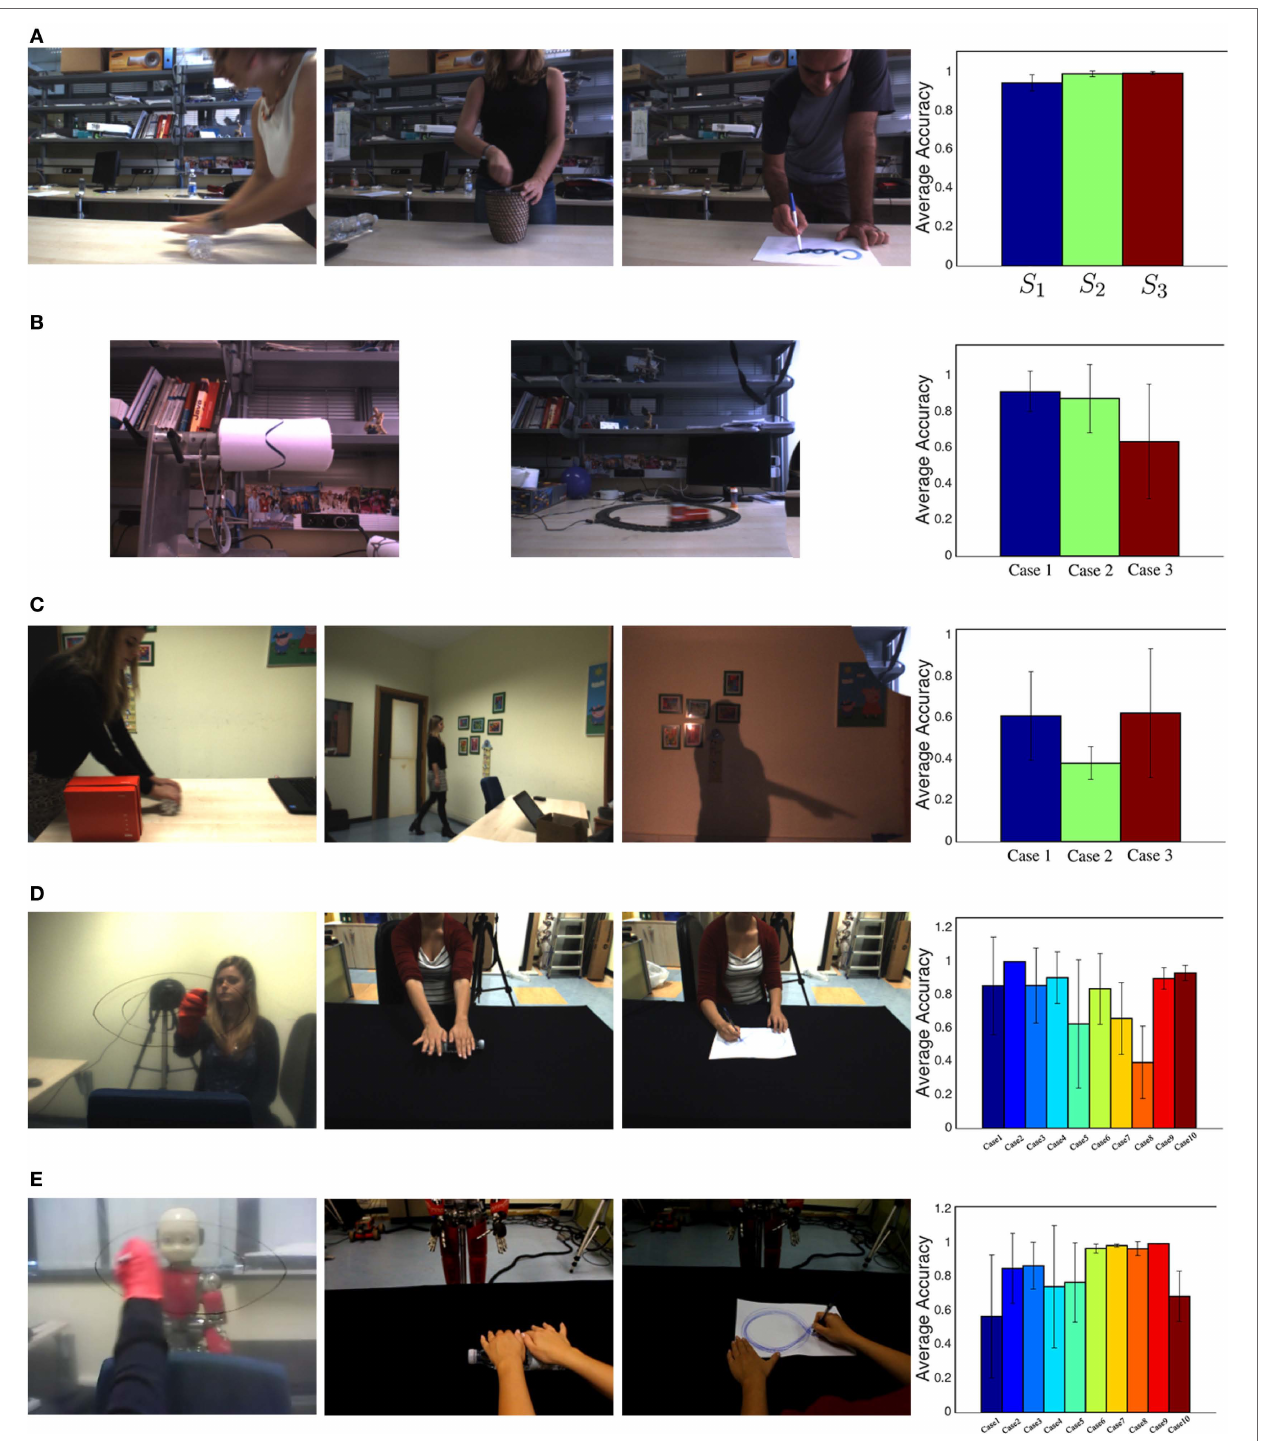
FIGURE 5 | Frames from sequences adopted in the Tests and graphs with the average classification accuracy (see the text for details on different cases for each Test) . The images are the ones that have been really used for the analysis: the low quality is due to both the resolution and the bad lighting condition. In some cases, the presence of a transparent board placed between the camera and the observed scene further affect the quality of the images. (A) Test I on new videos of biological movements observed during training. Each bar refers to a training subject. (B) Test II on movements with changing speed. (C) Test III on videos with occlusions, far events and shadows. (D) Test IV on novel dynamic events. (E) Test V on novel dynamic events observed from a different view-point.